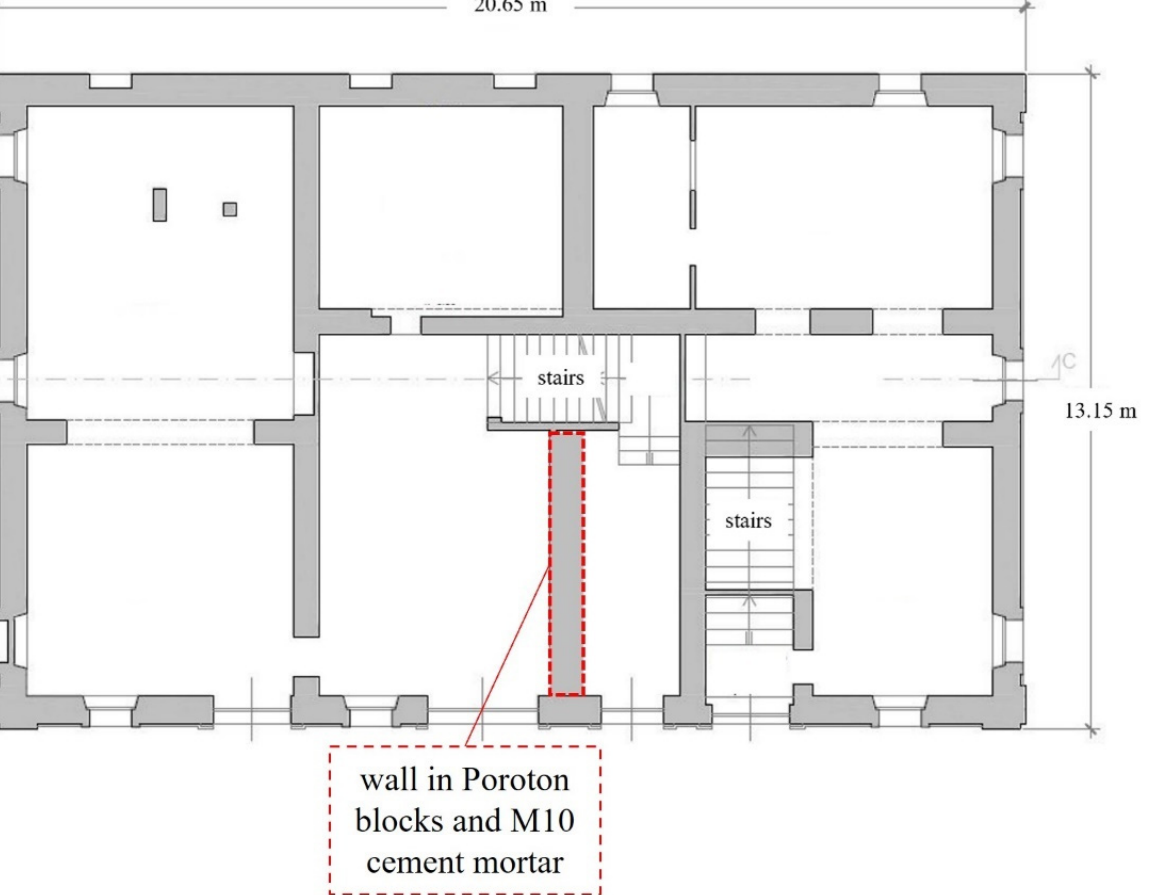
Figure 9. Retrofitted configuration of the wooden slabs (unit of measure in cm).